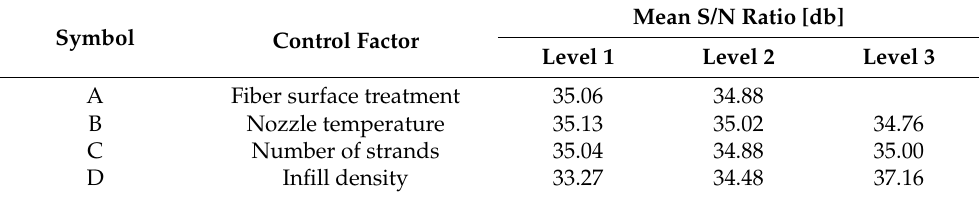
Table 7. Mean response table of the S/N ratio for flexural strength and significant